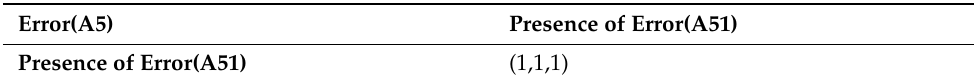
Table 9. Fuzzy-based comparison matrix associated with the sub-criteria in relation to the error (A5) criteria.